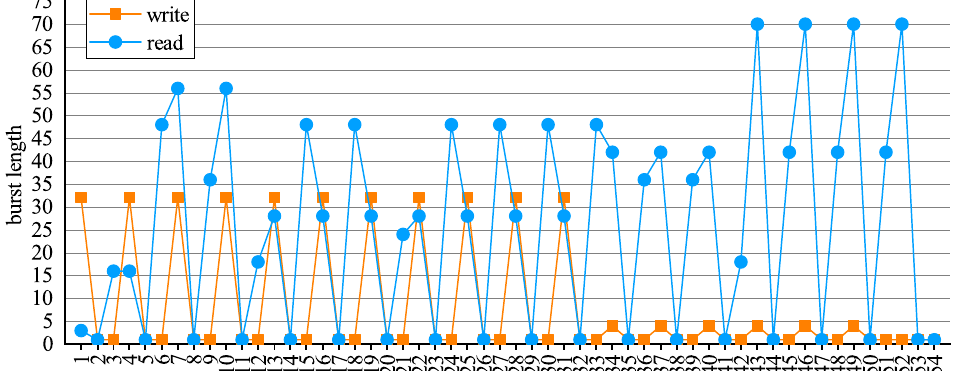
Figure 11. Burst length for the reading and writing of DDR4 of each